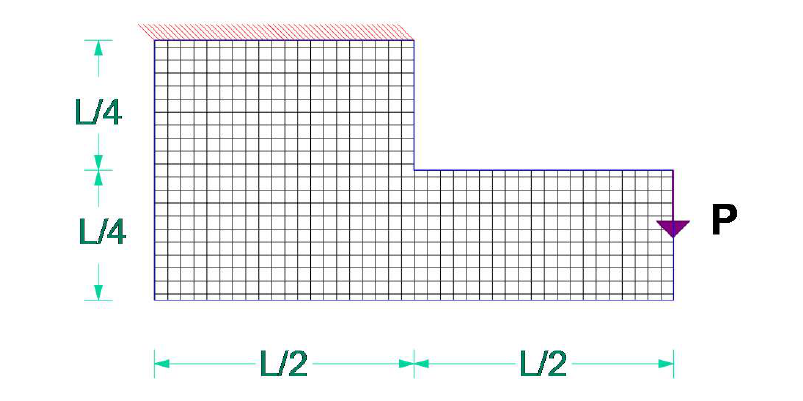
Figure 7. Definition of test example B.